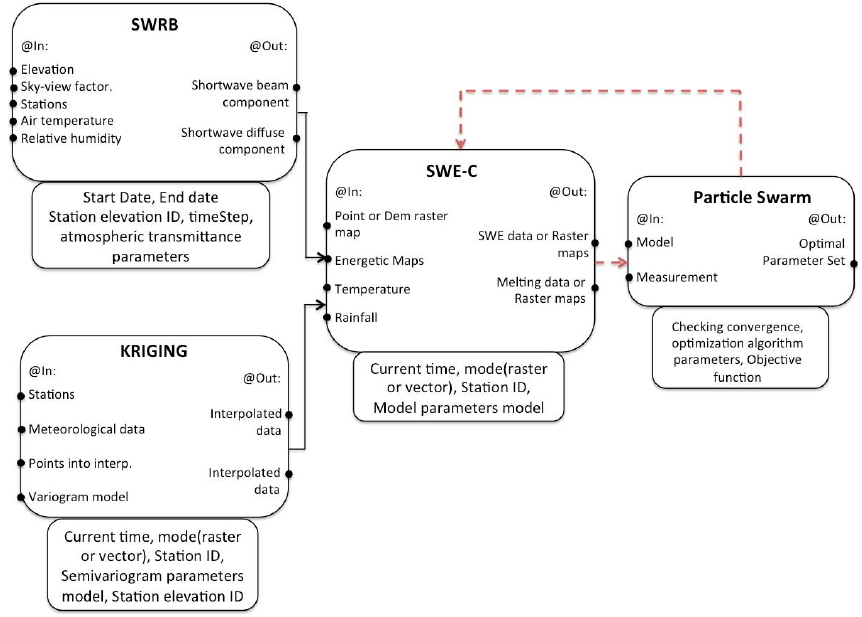
Fig. 2. The SWE-C integration into the NewAge system, showing connections with the shortwave radiation component and kriging interpo- lation algorithm. The connection with the particle swarm optimization algorithm is presented as a red dashed line.